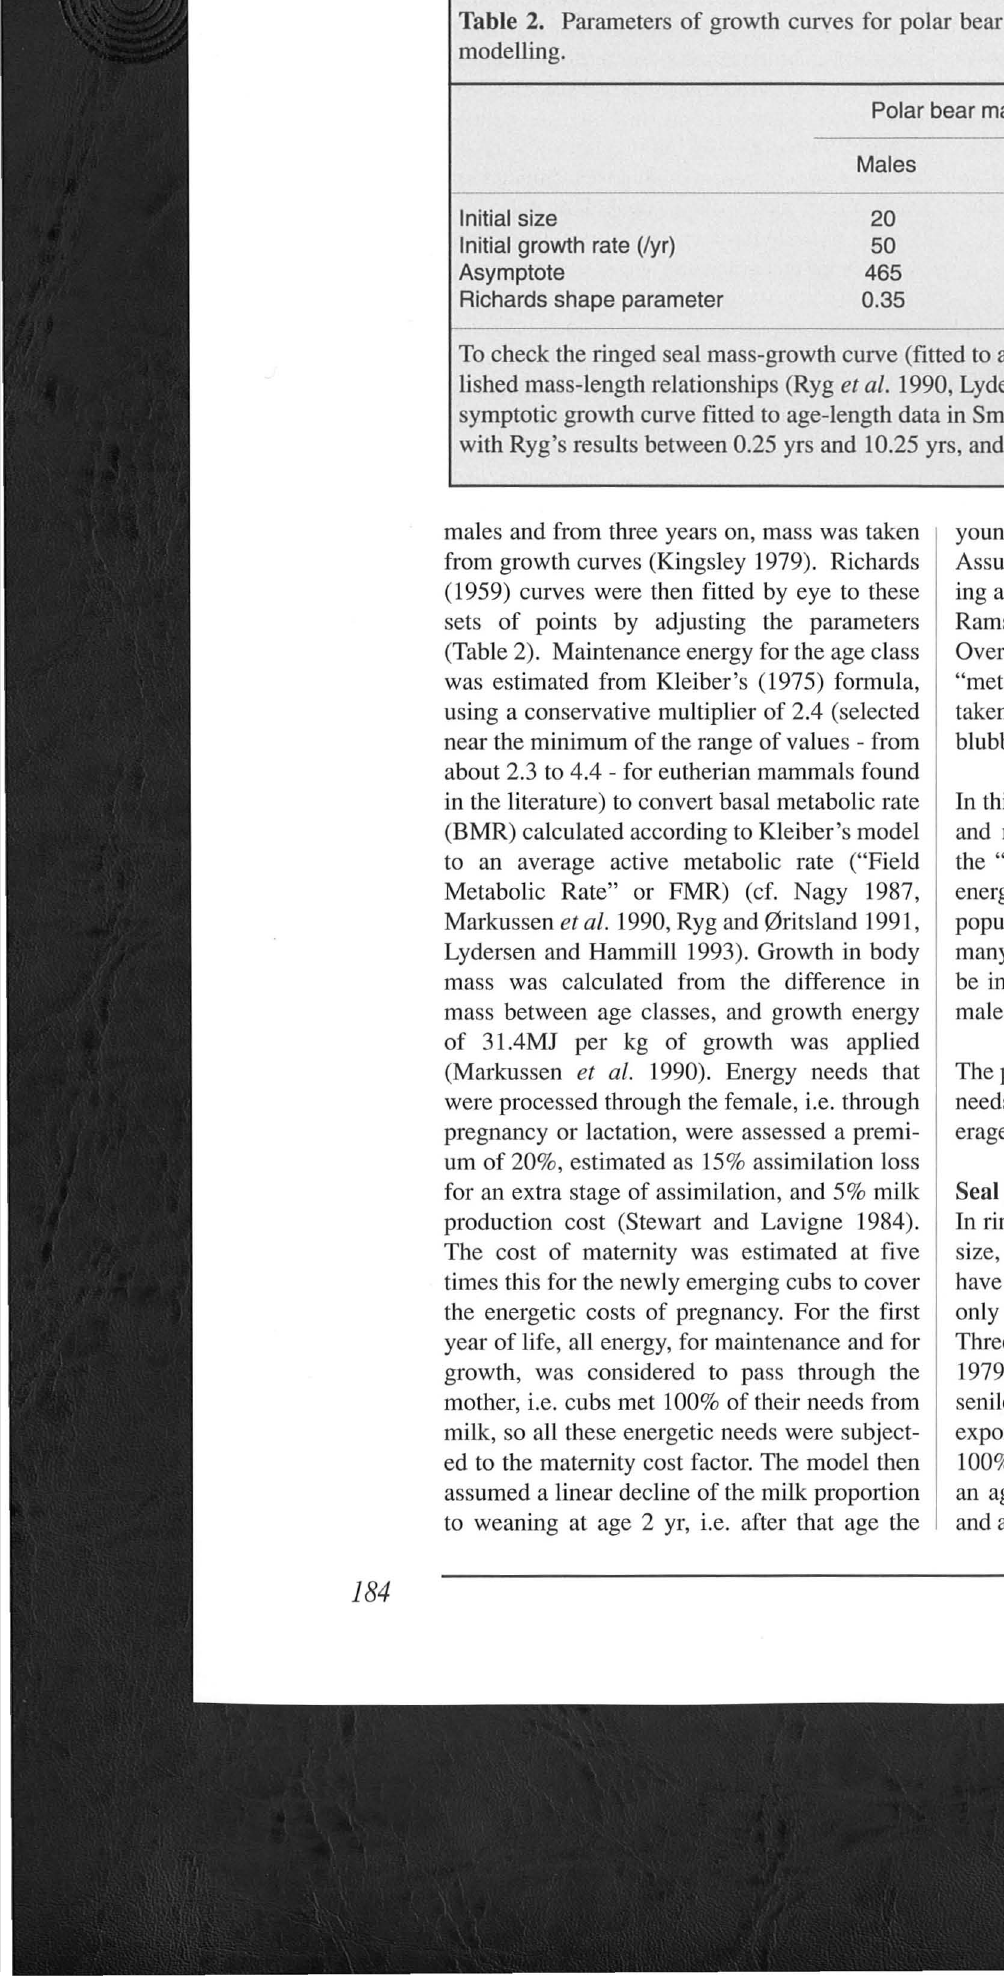
Table 2. Parameters of growth curves for polar bear and ringed seal body mass for energetics